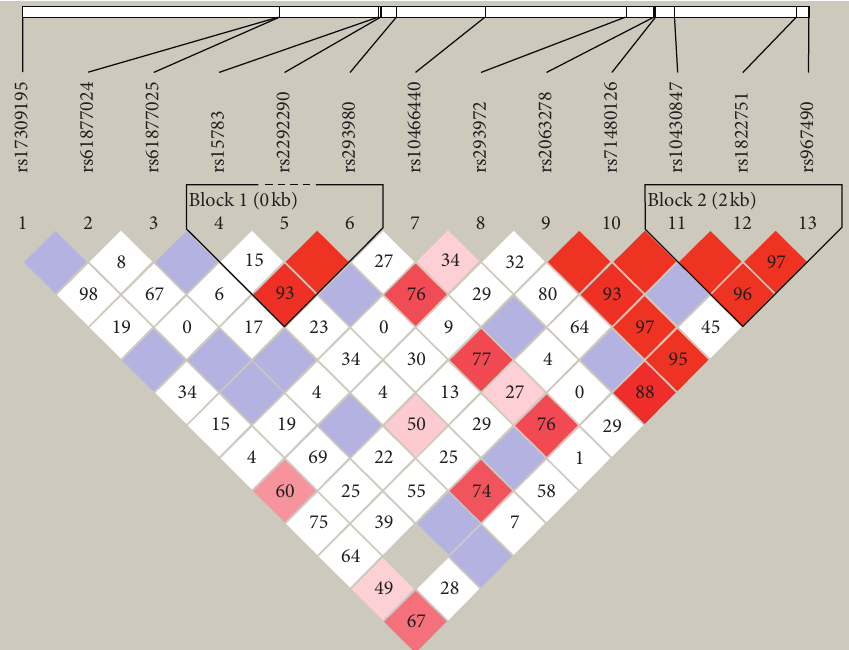
Figure 2: Graphical representation of the SNP locations and LD structure of MUC15. The SNP distribution and haplotype block structure across the MUC15 genes are shown, respectively. The measure of LD ( D 2 ) among all possible pairs of SNPs is shown graphically according to the shade of color, where white represents very low D 2 and dark represents very high D 2